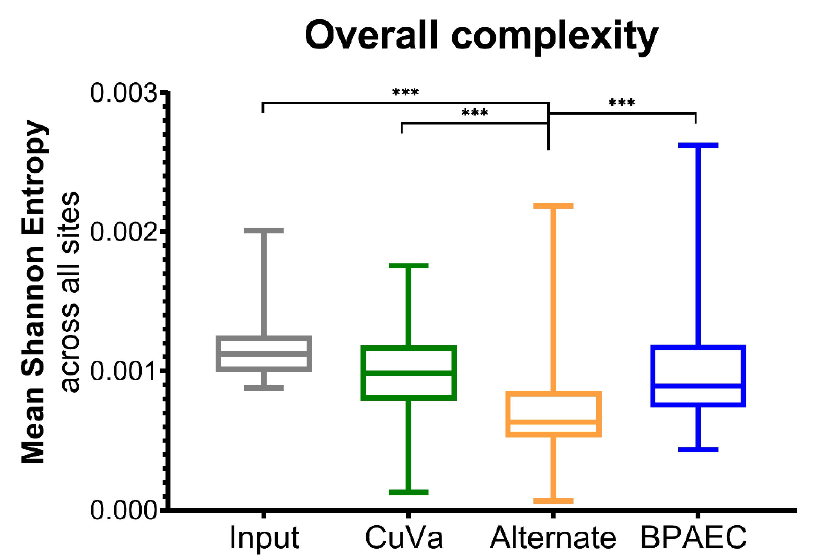
Figure 4. BTV Genetic Complexity across Cell Culture Conditions. Shannon entropy was calculated as a measure of population complexity across viral coding sequences. Shannon entropy was calculated for each segment and cumulative data from all segments are shown by box-and-whisker plots (median, interquartile range, and minimum/maximum are depicted; *** = p < 0.005). Box-and-whisker plots for BTV17-CUVA, -ALT, and -BPAEC were constructed using the mean Shannon entropy of all segments across passages 3, 6, and 9.